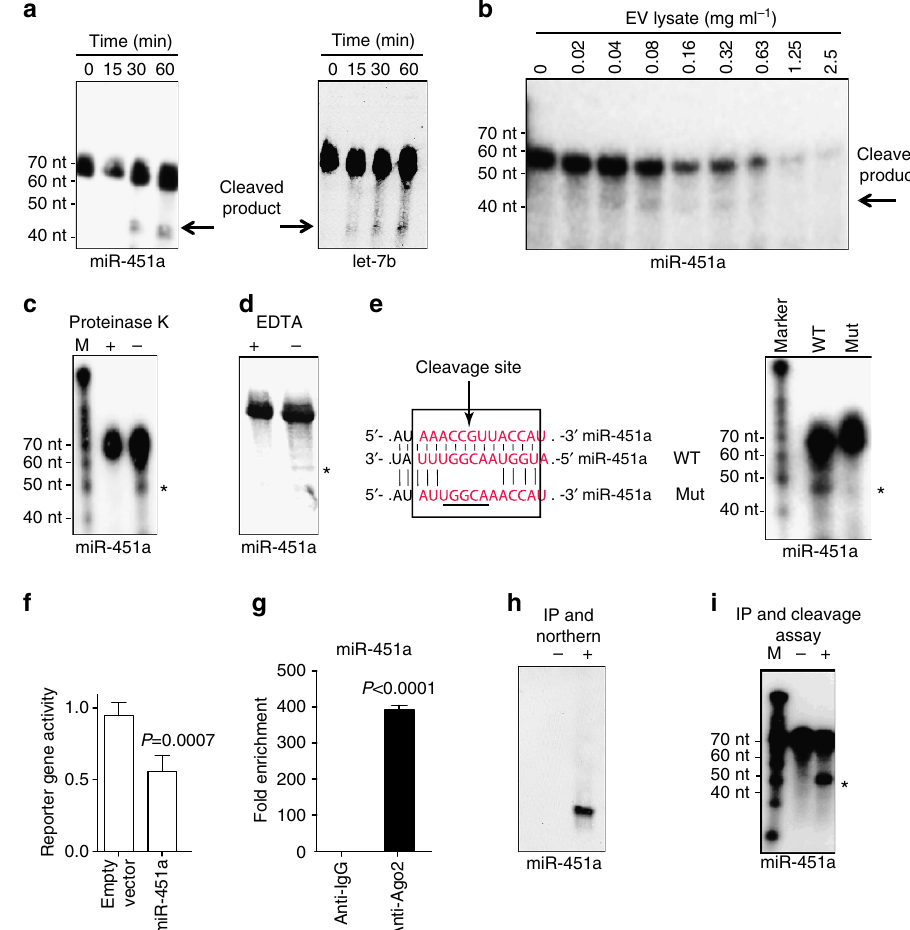
Figure 4 | Characterization of a functional Ago2-miRNA complex in EVs that are functionally competent in gene silencing. ( a , b ). In vitro RISC activity assay. ( a ) EV lysates were incubated for 0, 15, 30 or 60min in the presence of a 32 P-labelled RNA sensor with binding site complementary to miR-451a (left) or let-7b (right). The cleavage was monitored by gel electrophoresis. ( b ) miR-451a sensor was incubated for 90min with increasing amounts of EV lysate and emergence of processed product was monitored as above. The autoradiogram demonstrates emergence of product in a range between 0.04 and 0.32mg EV lysate per ml. ( c – e ) Specificity of endonucleolytic RISC activity. Co-incubation of EVs and miR-451a probe with 1mgml (cid:2) 1 of proteinase K ( c ) or EDTA ( d ) inhibits the cleavage reaction, while a DMSO control remains unaffected. ( e ) Disruption of the miR-451a cleavage site on the probe (Mut) blocks processing, while the wild-type probe (WT) is efficiently cleaved. ( f ) 3 0 -UTR degradation activity. HEK293 cells transiently expressing a Renilla luciferase reporter gene with binding site complementary to miR-451a in the 3 0 -UTR of the reporter cassette were incubated with EVs derived from iRBCs for 48h prior to luciferase activity measurements. Results are normalized based on constitutive Firefly luciferase activity, and expressed as mean ( ± s.e.m.) percentage of control ( n ¼ 3 experiments). P versus control (Student’s t- test). ( g , h ) Activity of purified Ago2-miRNA complex. ( g ) Quantification of miRNA by qRT-PCR. Protein extracts derived from purified EVs were subjected to immunoprecipitation (IP) using anti-Ago2 antibody, followed by miR-451a quantification using qRT-PCR. Results are normalized by the 2 -Ct method, using the RNU6 gene as a reference and expressed as the enrichment versus